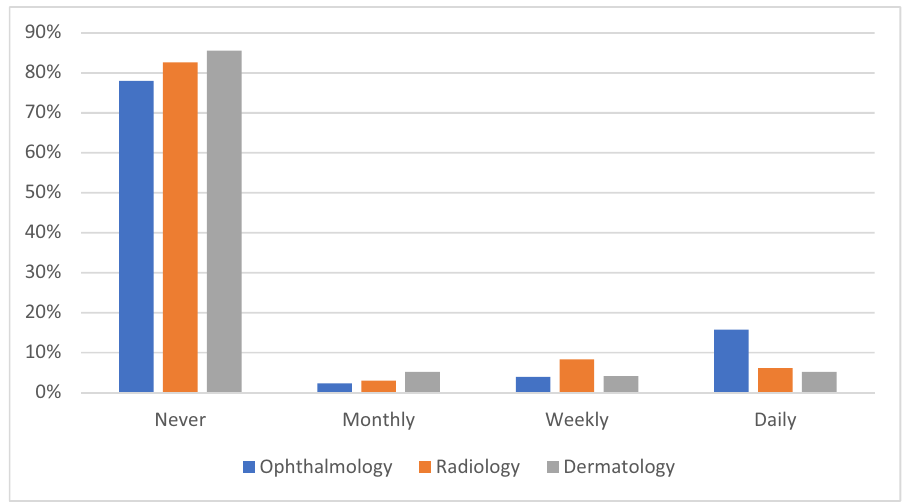
Figure 2. Current frequency of artificial intelligence use in clinical practice.